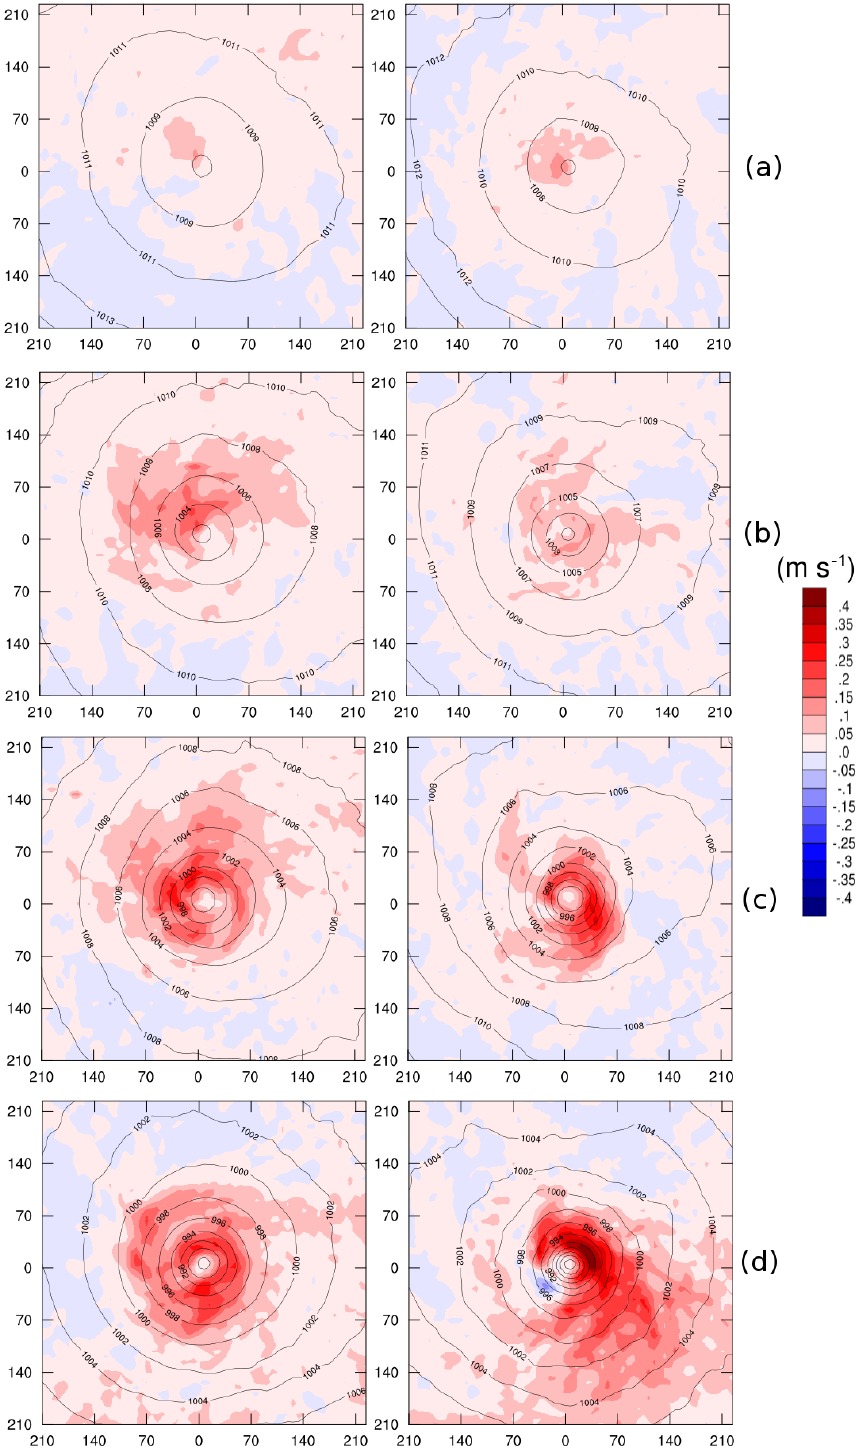
Figure 10. The 10h mean of composite vertical wind speed at 500hPa for an SST change of (a) − 3K, (b) 0K (original SSTs), (c) + 3K and (d) + 6K (colors), as well as composite mean sea level pressure (contours) between MWCT − 20h and MWCT − 10h (left column) and between MWCT − 10h and MWCT (right column). The values on the x and y axis indicate the distance from the center of the medicane in